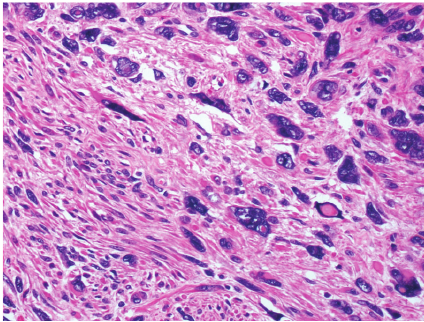
Figure 4: H&E section.